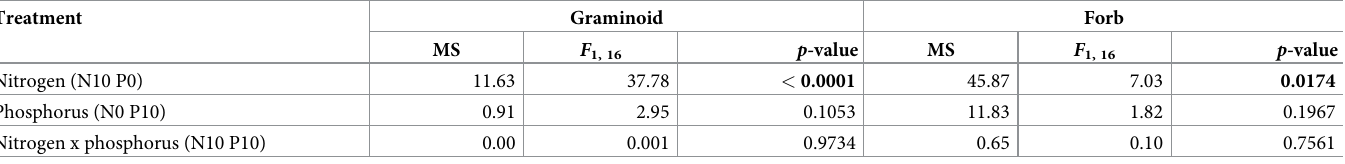
Table 1. Effects of nitrogen, phosphorus, and nitrogen + phosphorus additions on graminoid and forb productivity compared to control based on two-way ANOVA. Treatment Graminoid